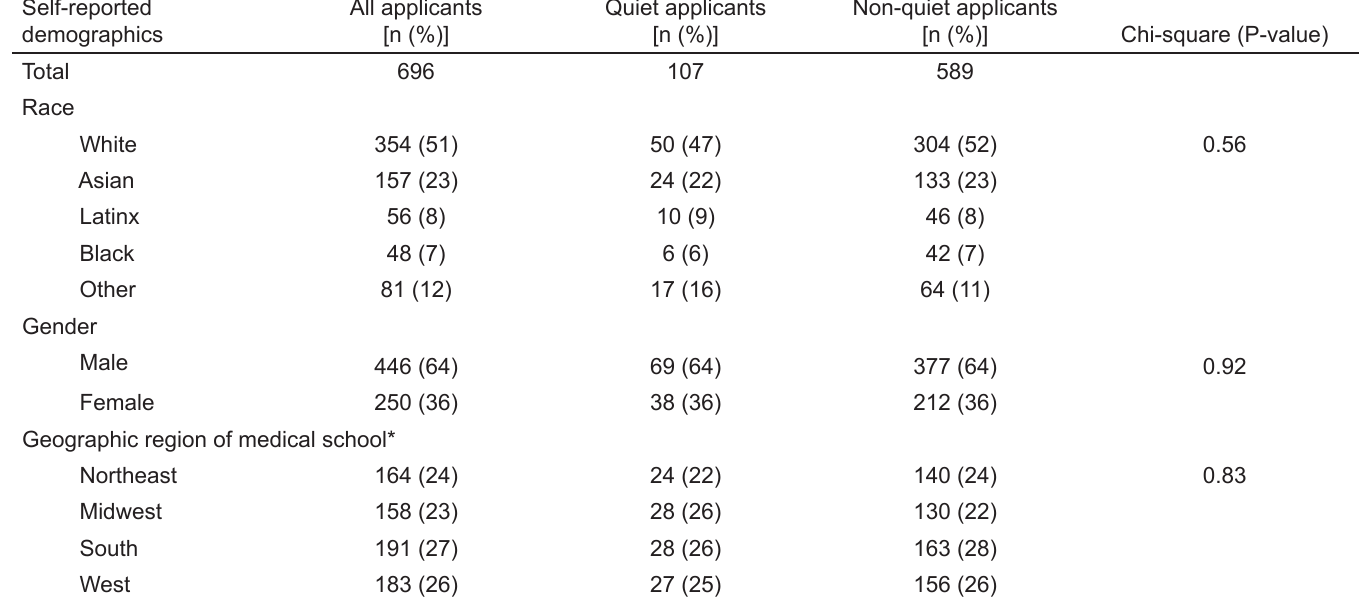
Table 1. Applicant demographic